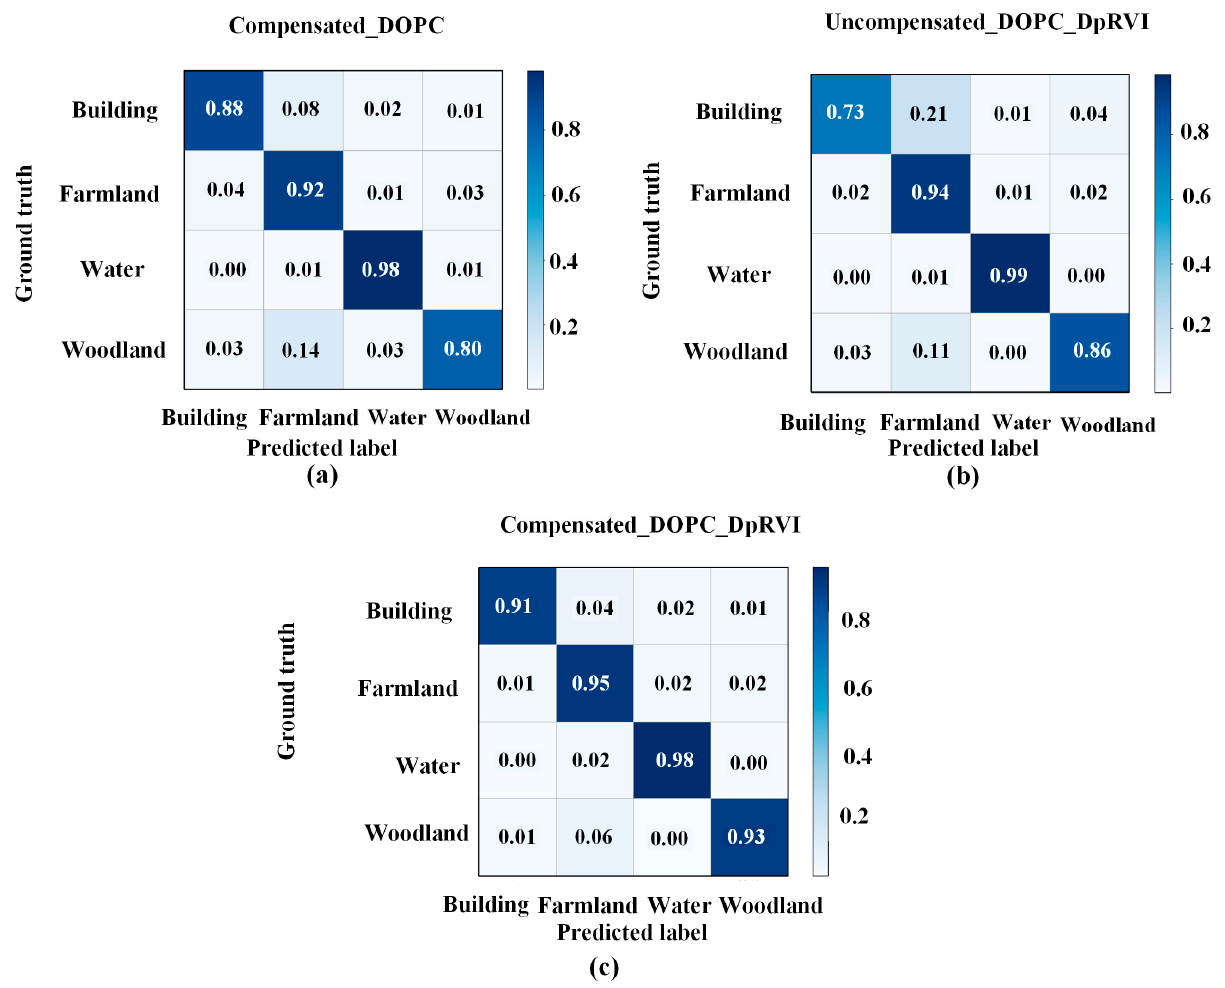
Figure 14. Confusion matrix of the feature combinations: ( a ) Compensated_DOPC; ( b ) Uncompen- sated_DOPC_DpRVI; ( c ) Compensated_DOPC_DpRVI. Table 3. Quantitative evaluation of the model generated by the combinations of features. Building Farmland Woodland